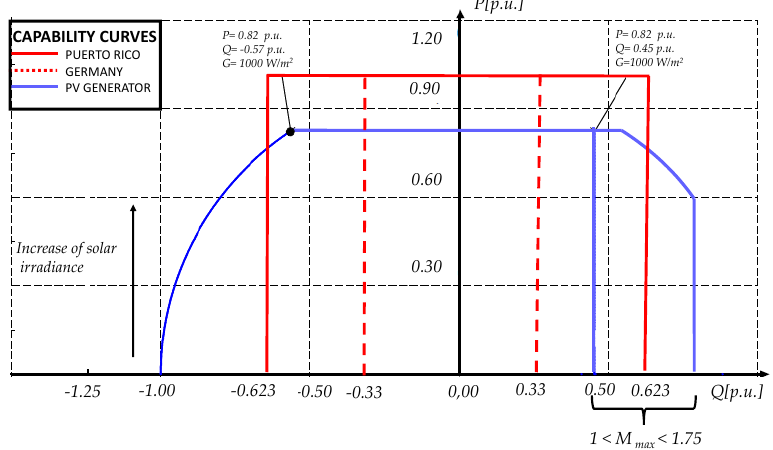
Figure 30. Capability curves comparison considering the grid codes of Puerto Rico, Germany and the capability curve extracted from the current study